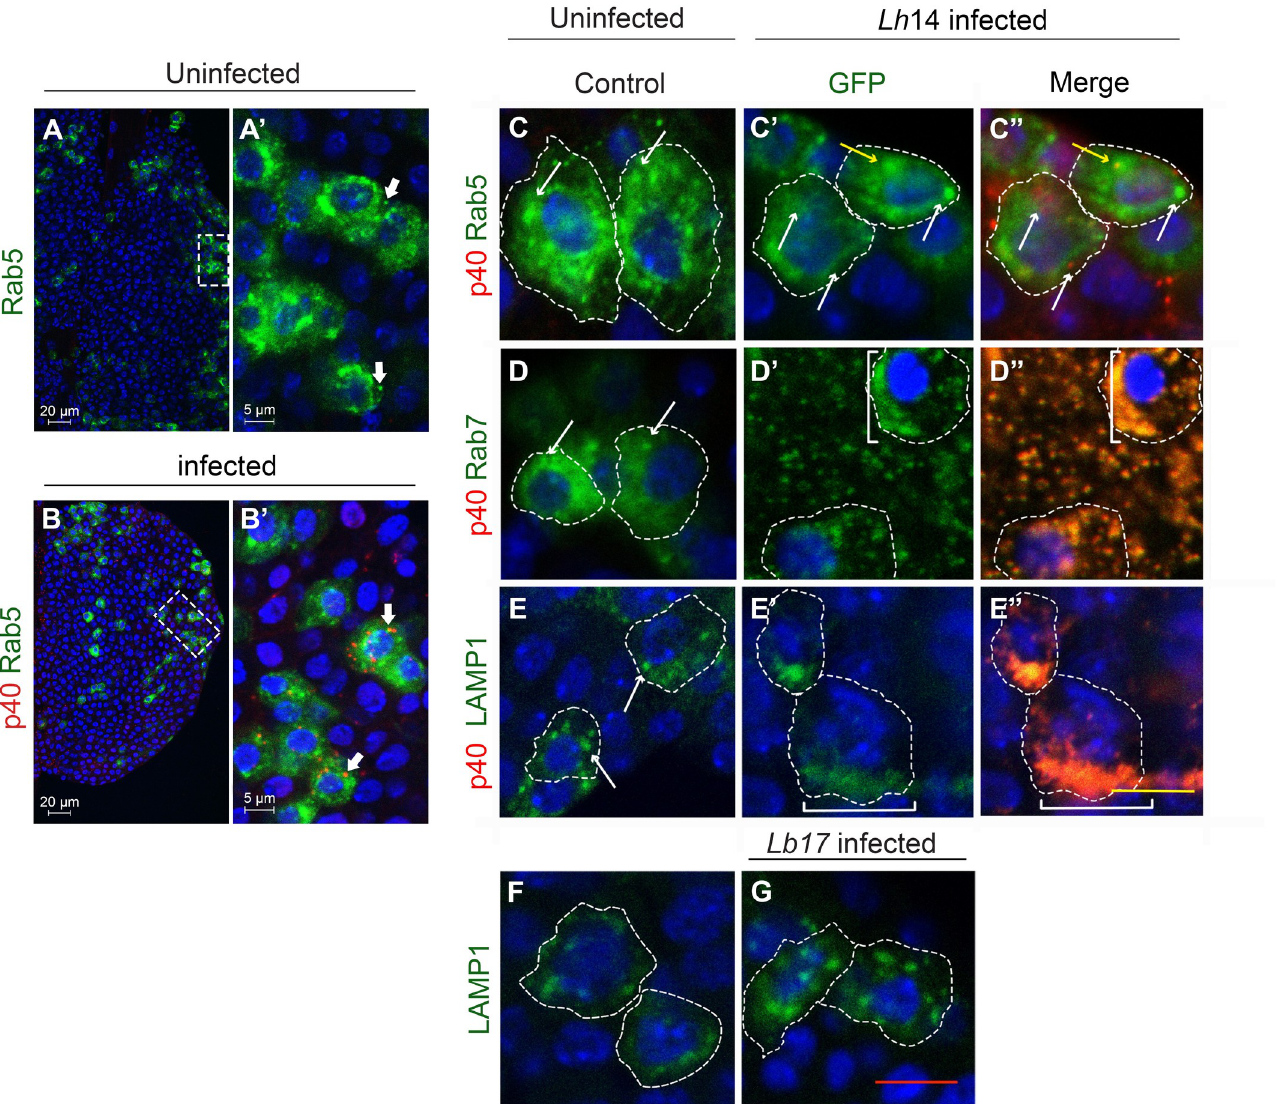
Fig 5. Effects of Lh and Lb infection on retrograde transport organelles. ( A, B ) Hemese > GFP-Rab5 lymph glands stained with anti-SSp40; Lh EVs enter Rab5 compartments, some EVs colocalize with GFP-Rab5 (arrows). ( C-E ) Hemese > GFP-Rab5 , > GFP-Rab7 , and > GFP-LAMP1 expression in na ï ve animals or Lh - infected animals as shown. Individual cells are outlined. Yellow arrow in C’ and C” shows a normal Rab5 compartment with EV signal. White arrows point to normal compartment morphologies. Square brackets (D’,D”, E’,E”) point to grossly distorted Rab7 and LAMP1 compartments associated with Lh EVs. ( F, G ) Lb infection does not distort LAMP1 compartment